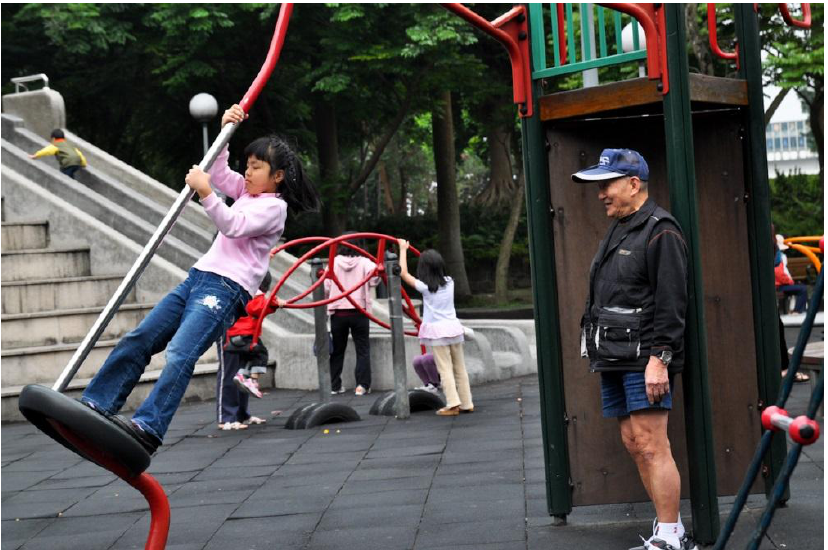
Figure 2. Example of intergenerational interaction in Taipei green space.